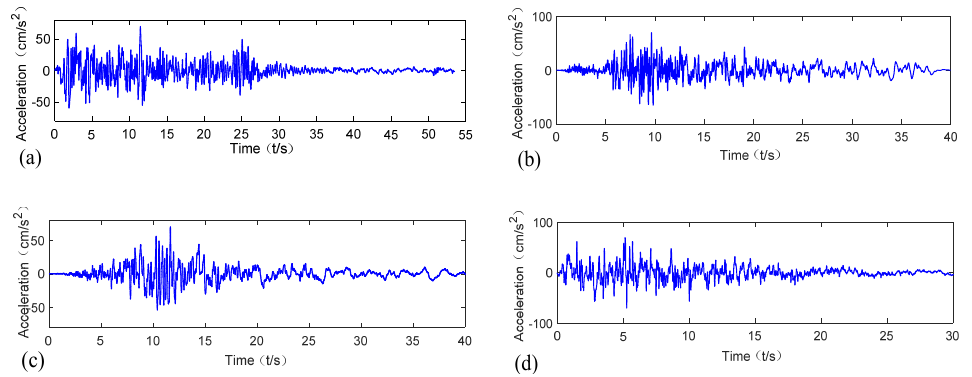
Figure 9. Ground motion input: ( a ) El Centrol (1940); ( b ) Imperial Valley − 06 (1979); ( c ) Loma Prieta (1989); and ( d ) artificial.